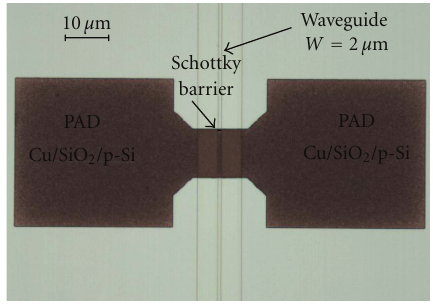
Figure 7: Top view of the proposed Si waveguide photodetector.